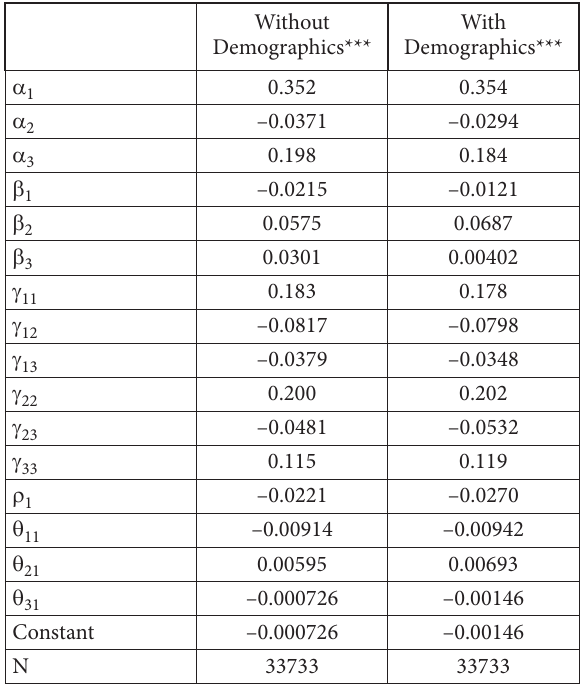
Table 4. AIDS for Housing Attributes (AIDS-HA)